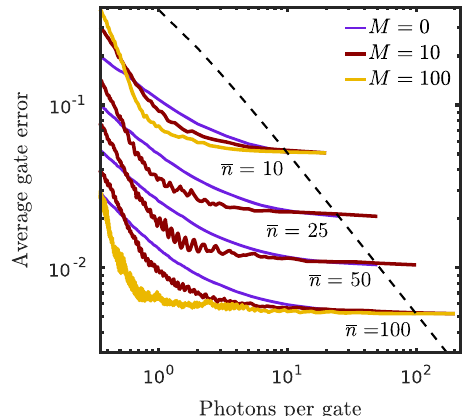
Fig. 5 Average gate error as a function of the photon cost per gate, 2 n = N for M > 0 and n = N for M = 0. Here, n is the mean number of photons in the initial pulses and N is the number of X π register gates generated by the protocol. The ancilla states are non-ideally prepared by a corrector pulse initially in state (cid:3) During the protocol, the curve advances from right to left as 1/ N decreases. The results are averaged over multiple simulations. The dashed line indicates the lower bound of error which is achieved with a single disposable optimal